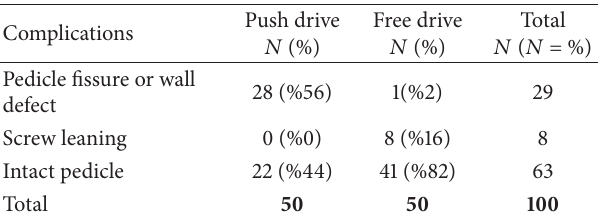
Table 2: Distribution of results in the “free drive” and the “push drive”